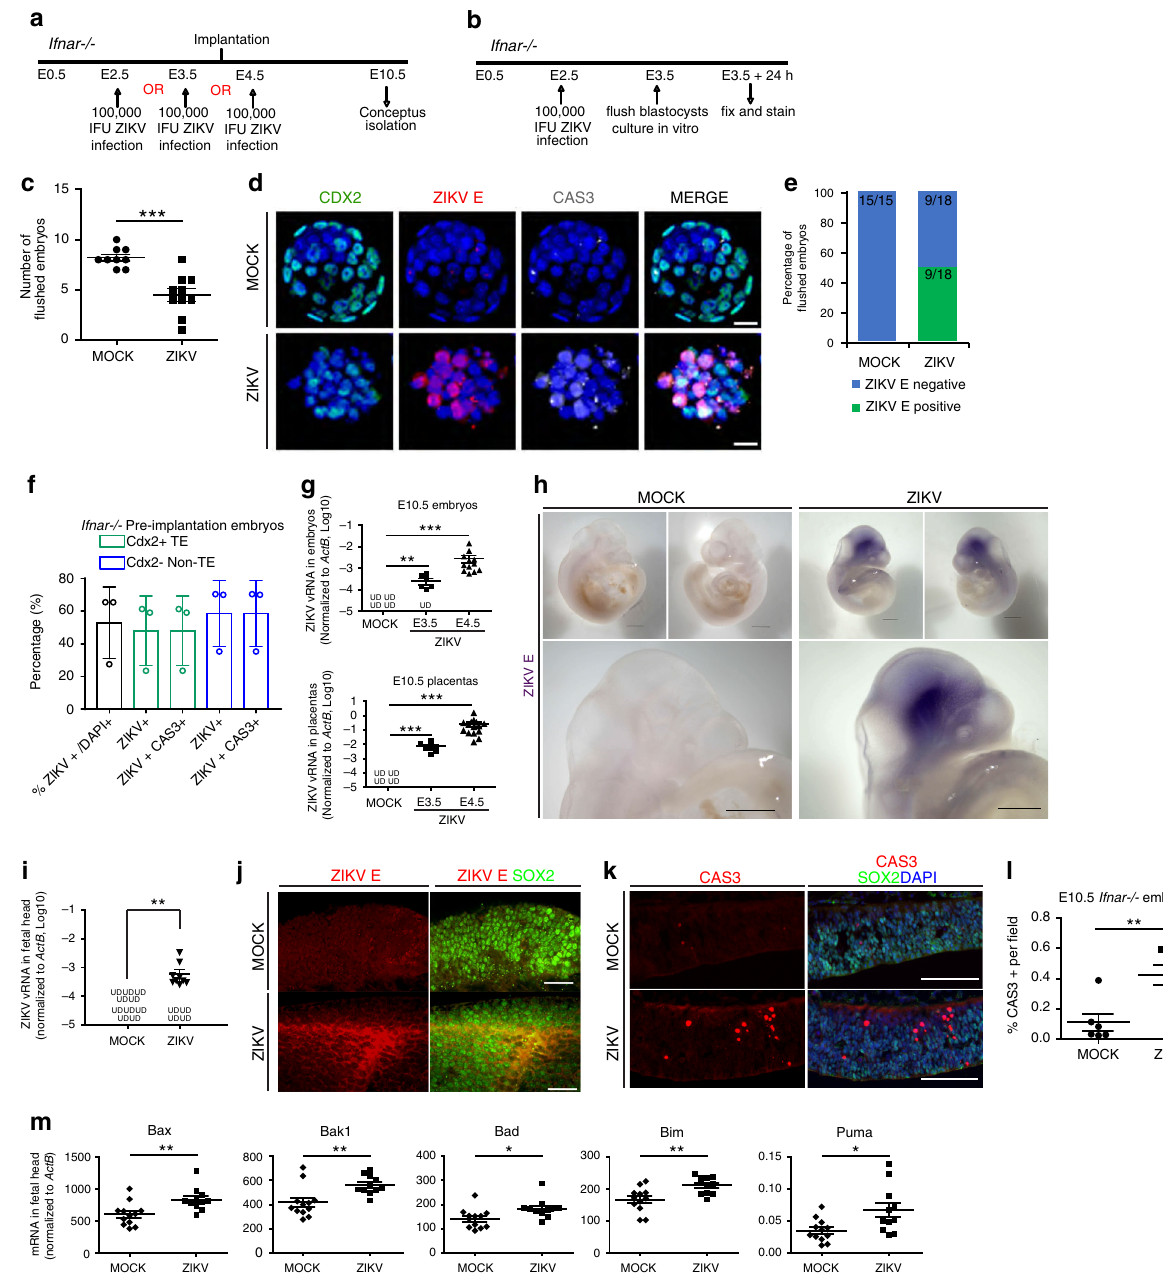
Fig. 4 Effects of pre- and peri-implantation ZIKV infection on mouse embryos. a Scheme of ZIKV infection in pregnant Ifnar − / − mice. b Scheme of ZIKV infection of mouse blastocysts in vivo and propagation in vitro. c Number of blastocysts recovered from pregnant Ifnar − / − mice infected in b . n = 9 MOCK, n = 10 ZIKV. d Immunostaining of ZIKV E and CAS3 in blastocysts infected in b . Scale Bar = 20 µ m. e Percentage of recovered blastocysts staining positive and negative for ZIKV E infected in c . n = 15 MOCK, n = 18 ZIKV. f Quanti fi cation of ZIKV E and CAS3 among CDX2 + and CDX2 - cells from blastocysts infected in b . n = 3. g Quanti fi cation of ZIKV vRNA level in E10.5 embryos (upper) and placentas (lower) infected at E3.5 and E4.5 in a . n = 4 for MOCK embryos and placentas, n = 7 for E3.5 embryos and placentas, and n = 12 for E4.5 embryos, n = 15 for E4.5 placentas. h Whole- mount chromogenic immunohistochemistry for ZIKV E antigen (purple precipitate) in E10.5 embryos of Ifnar − / − dams infected at E4.5 in a . Scale bar = 500 µ m. n = 3. i Quanti fi cation of ZIKV vRNA level in heads of E10.5 embryos infected in a . n = 10 for MOCK, n = 13 for ZIKV. j Co-staining of SOX2 with ZIKV E in E10.5 embryonic brains infected in a . Scale bar = 50 µ m. k Co-staining of CAS3and SOX2 in E10.5 embryonic brains infected in a . Scale bar = 100 µ m. l Quanti fi cation of CAS3 + area in k . n = 6 sections each. m Quanti fi cation of apoptotic genes expression in heads of E10.5 embryos infected in a . n = 12 for MOCK, n = 11 for ZIKV. UD – undetectable. Data are presented as mean ± standard deviation. P values were calculated by unpaired two-tailed Student ’ s t- test. * P < 0.05, ** P < 0.01, and *** P < 0.001. Related to Supplementary Fig. 3. Source data for 4b, d, f – h, j, m, n are provided as a Source Data fi